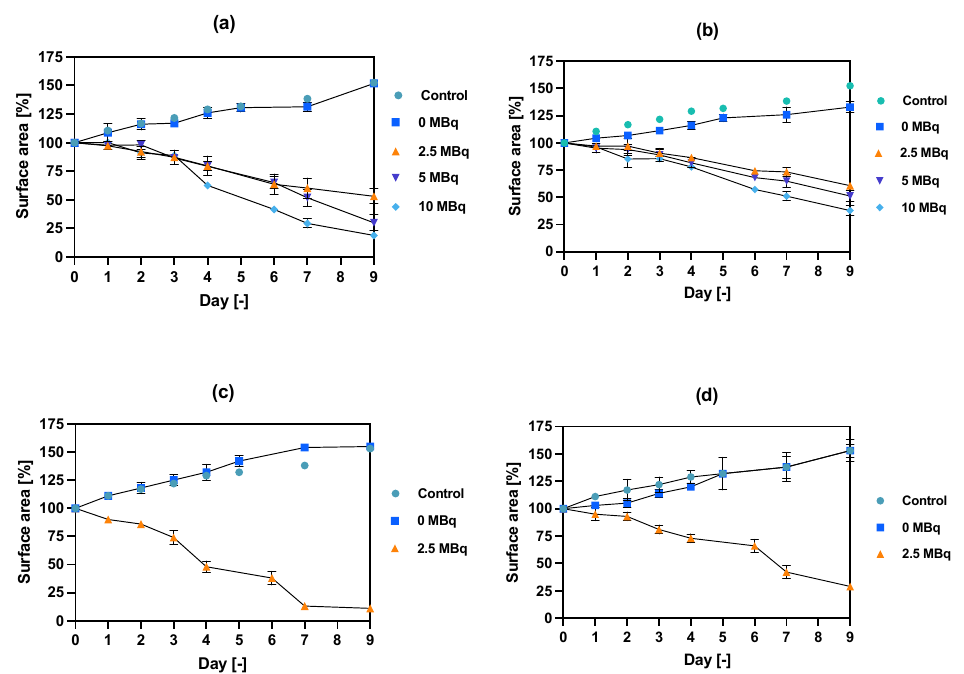
Figure 7. Spheroid growth over time treated with different activities of NPs bioconjugates: ( a ) radioactive NPs-PEG, 1 h incubation; ( b ) radioactive NPs-Tmab, 1 h incubation; ( c ) radioactive NPs-PEG, 18 h incubation; ( d ) radioactive NPs-Tmab, 18 h incubation. For some experimental data the error bars are the size of the solid symbols used. Data are expressed as mean value ± SD ( n = 3).